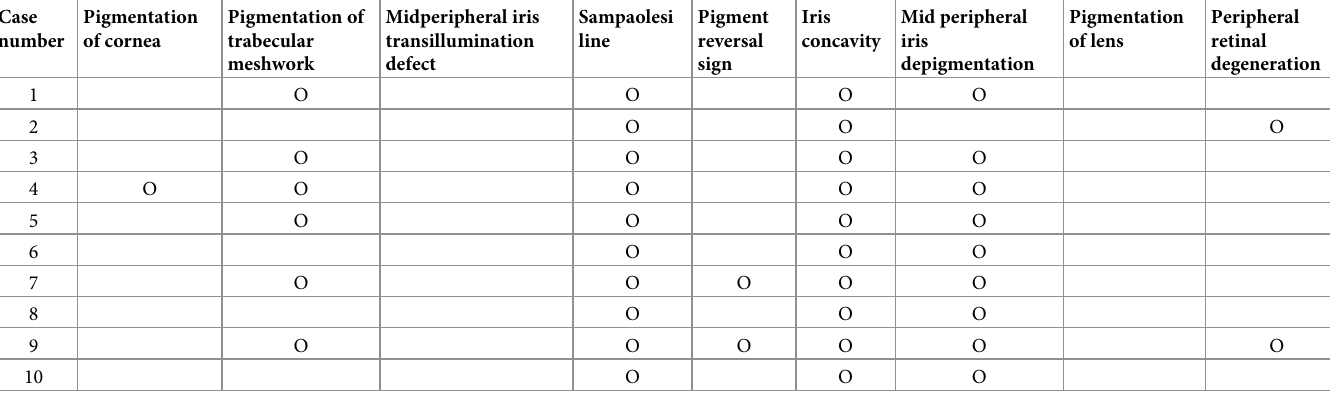
Table 2. Classic diagnostic triad and other findings of patients with pigmentary